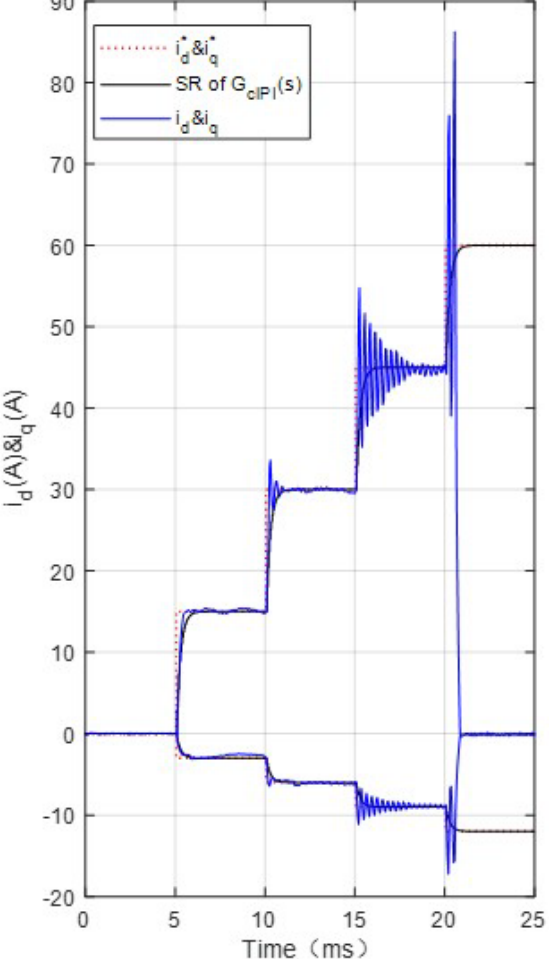
Figure 15. Experiment result of PI controller based on DIMC ( α = 4000 rad/s) of the locked saturated machine.